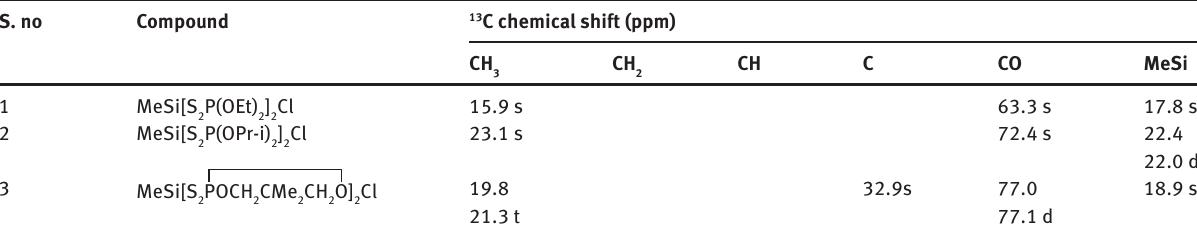
s, Singlet; d, doublet; t,